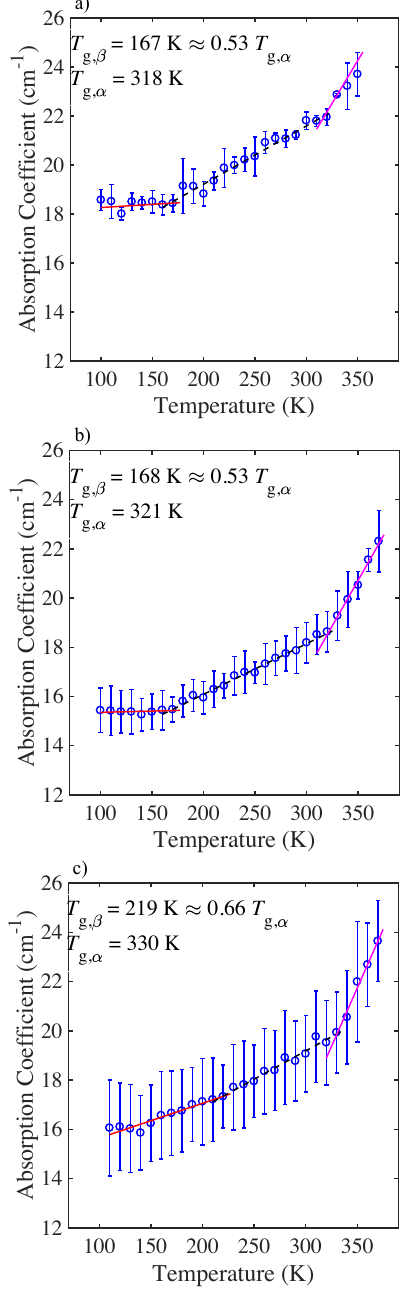
Figure 4. Mean terahertz absorption coefficient as a function of temperature at 1THz for PLGA 50:50 microspheres. Error bars represent the standard deviation for n samples. ( a ) blank ( n = 3), ( b ) low ( n = 4), and ( c ) high peptide loading ( n = 3). Lines show the different linear fits of the respective